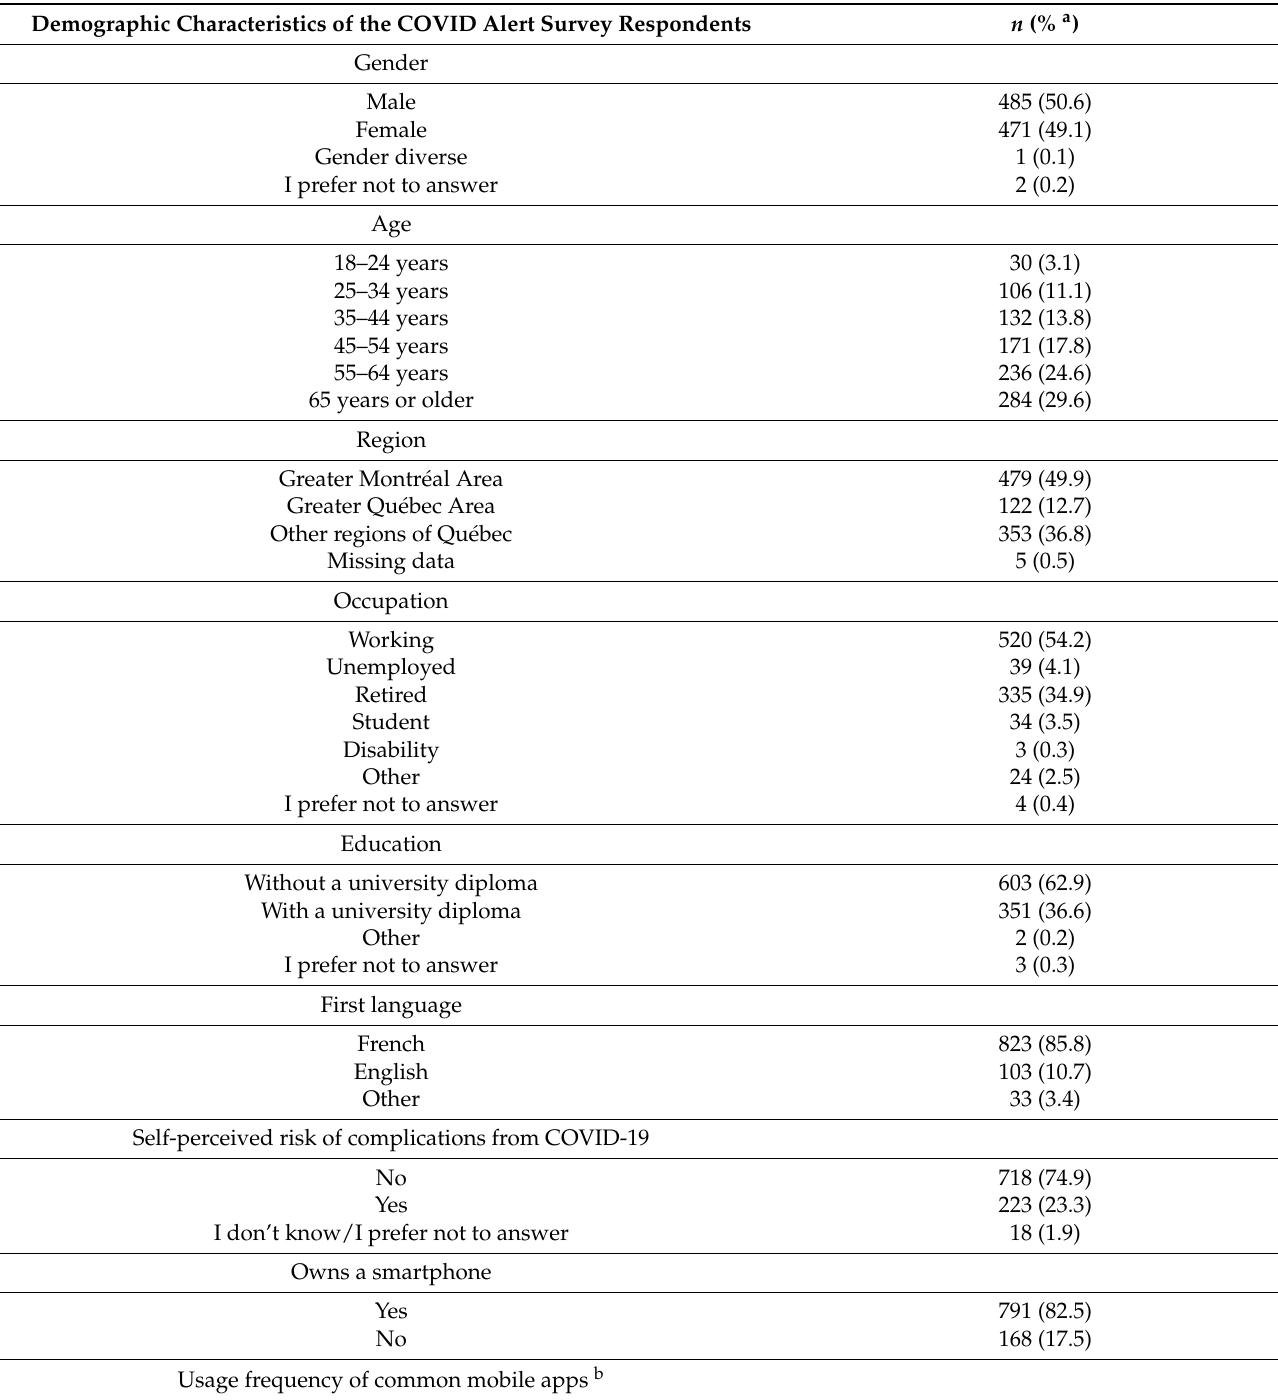
Table 1. Demographic characteristics of the survey respondents